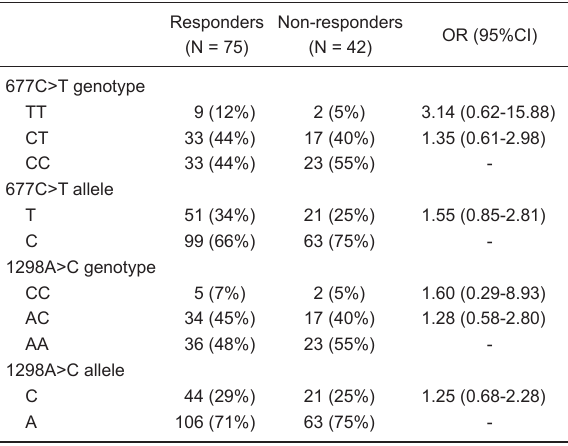
Table 2. 677C>T and 1298A>C genotypes and rheumatoid arthri- tis patients’ response to treatment.